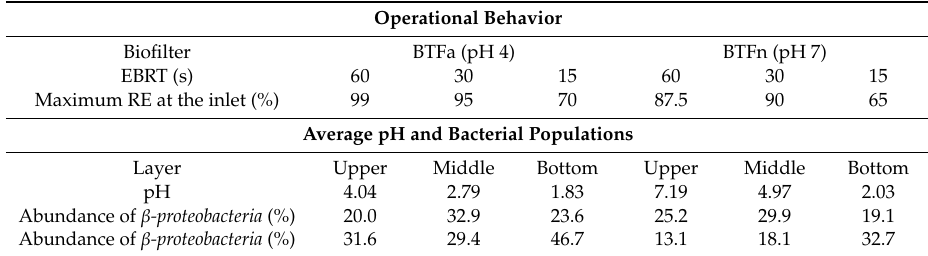
Table 4. Comparison of the operational behavior, pH and bacterial populations in two BTFs operated under acidic (a) and neutral conditions (n). EBRT: empty bed residence